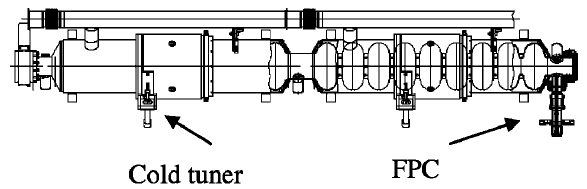
FIG. 1. SST-II: the left subunit is assembled in a He vessel with cold tuner. The right one is shown with the single FPC needed to transfer rf power to 18 cells.